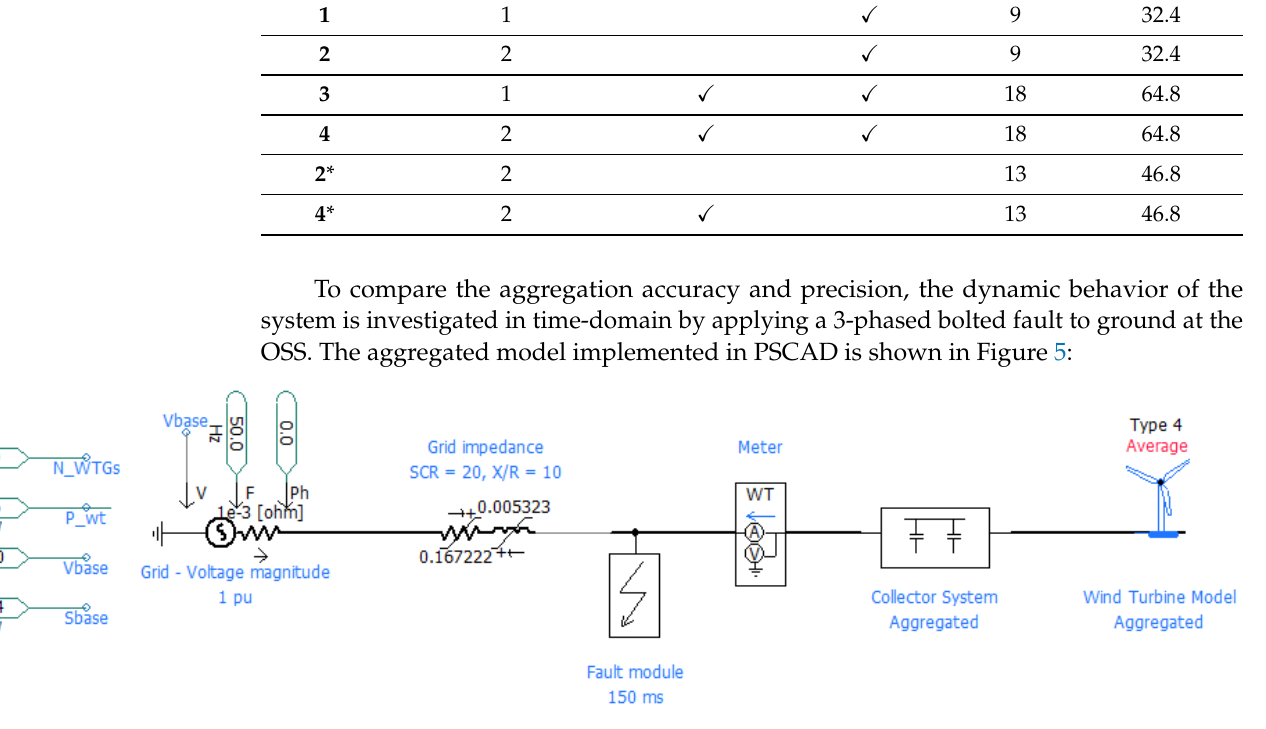
Figure 5. Representation of the aggregated system in time-domain simulation studies in